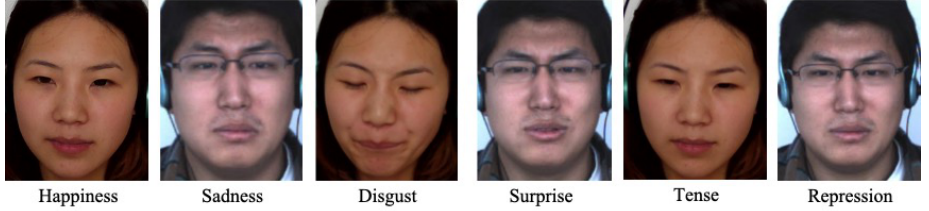
Figure 9. Examples of frames from sequences in the Chinese Academy of Sciences Micro-Expressions (CASME) data set